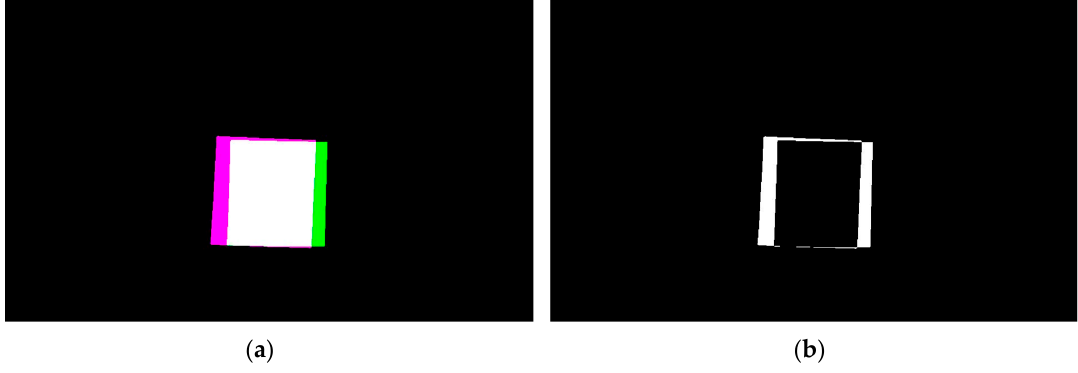
Figure 8. Comparison between the set point image and subsequent image. ( a ) Overlay of image 1 and image 2; ( b ) Image subtraction of image 1 and 2.